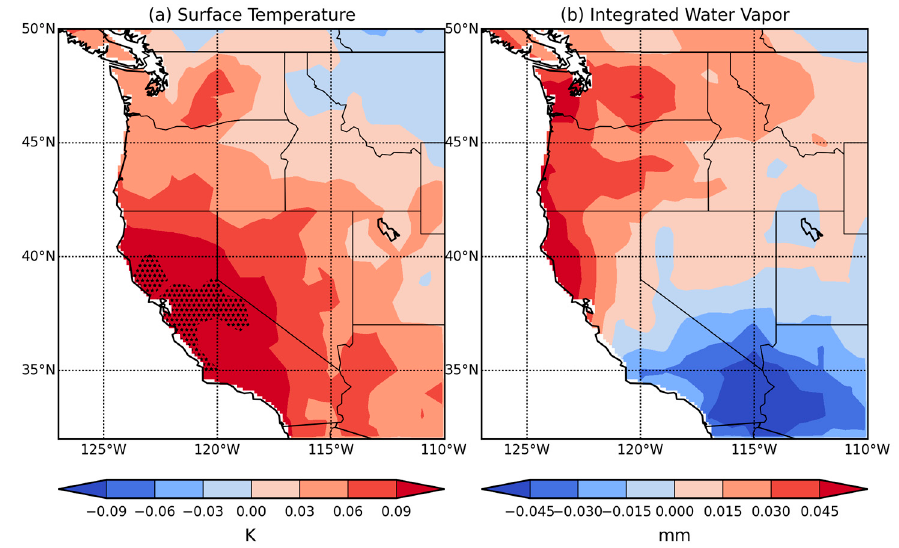
Figure 6. The total change in winter ( a ) surface air temperature and ( b ) atmospheric water vapor over the western United States between 2003 and 2016. Hatching indicates where the changes are statistically significant.